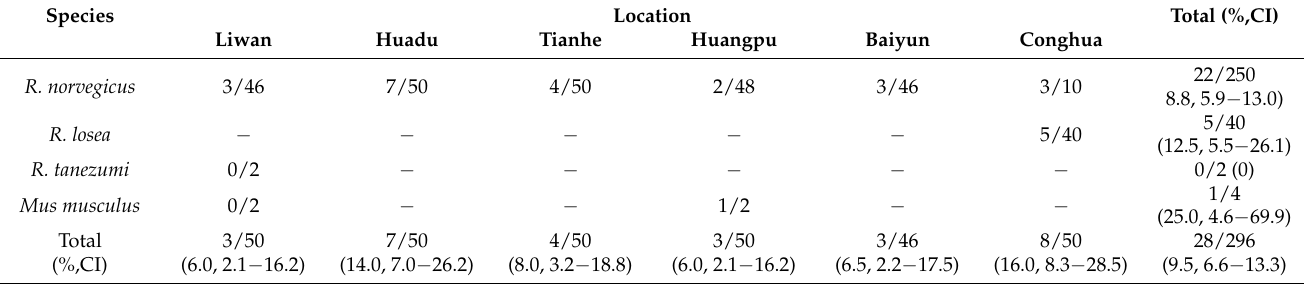
Table 2. Prevalence of pathogenic Leptospira in rodents by species and location in